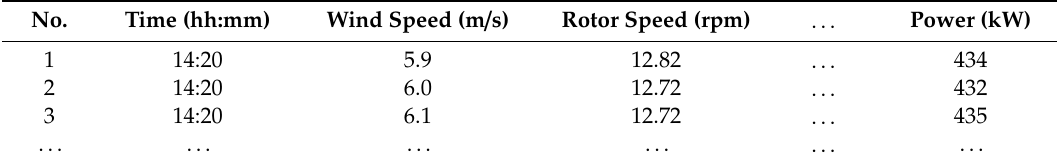
Table 1. Raw SCADA